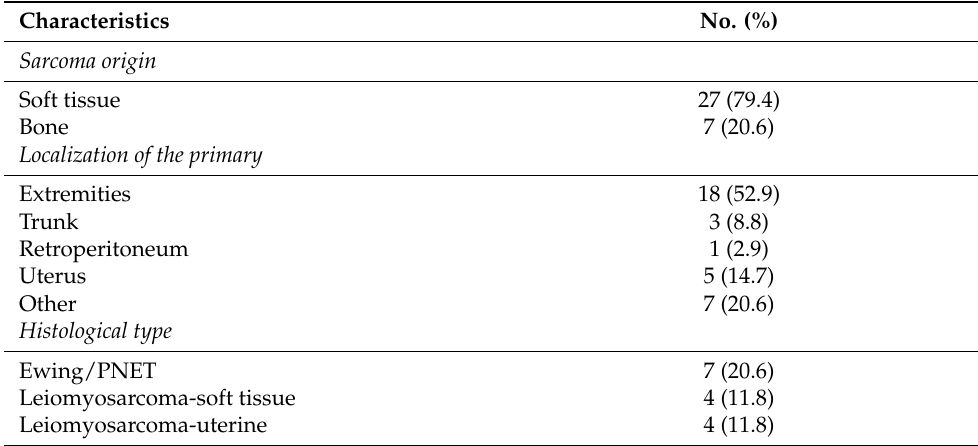
Table 1. Characteristics of the primary